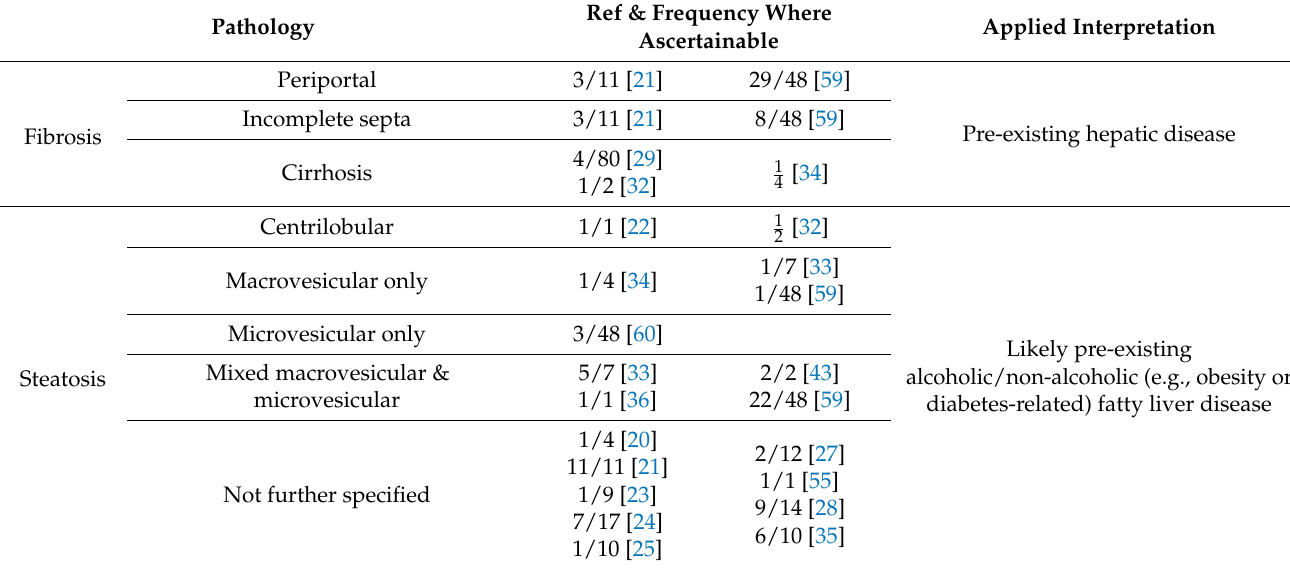
Table 3. Post-mortem hepatic pathology in COVID-19 described in published